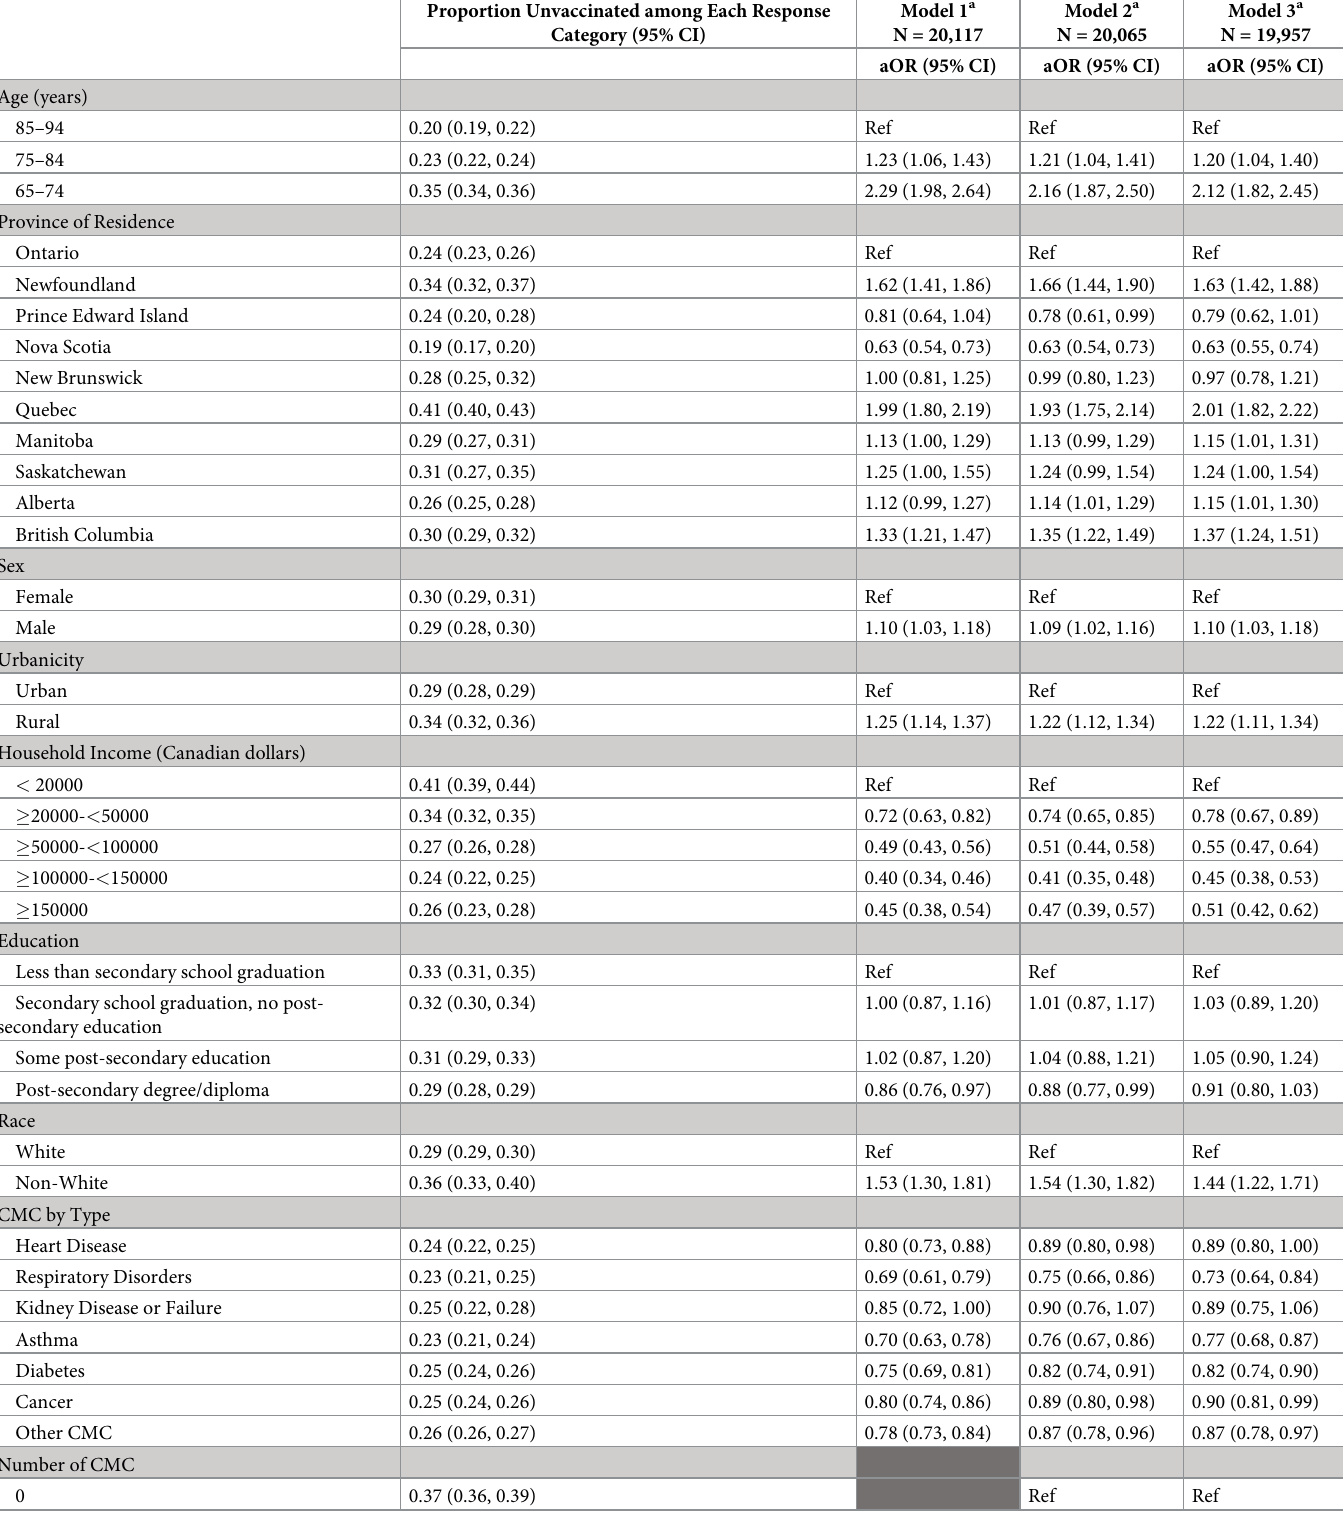
Table 3. Factors associated with seasonal influenza non-vaccination among Canadian residents aged 65 years and older (N =